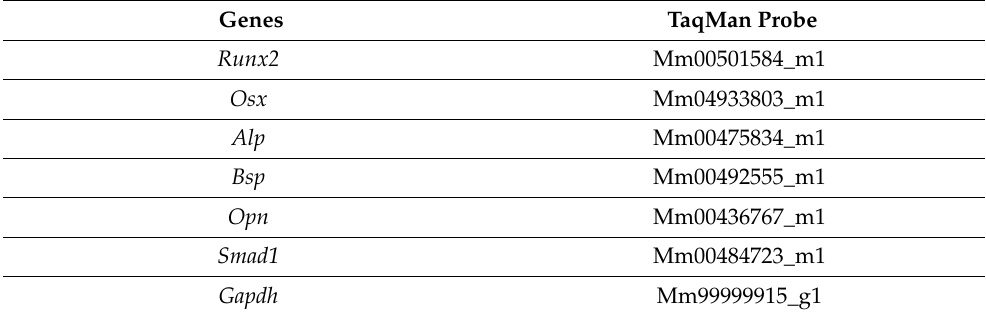
Table 1. TaqMan probes used in real-time PCR